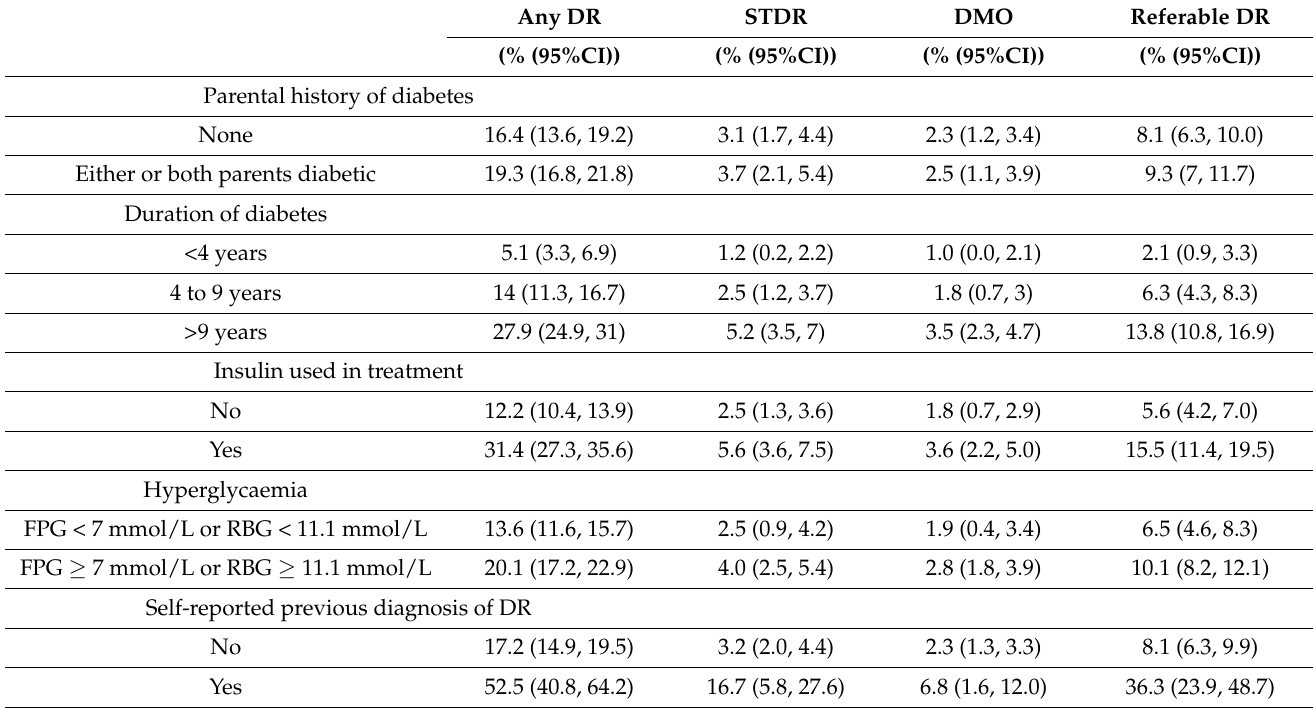
Table 6. Age- and sex-standardised prevalence of DR according to diabetes-related factors ( N = 4527). Any DR STDR DMO Referable DR (% (95%CI)) (%